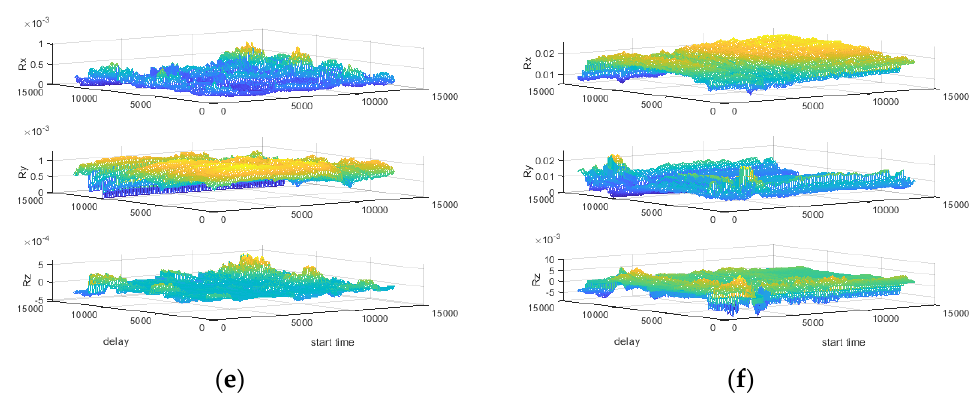
( e ) ( f ) Figure 3. The magnitude of each component of the magnetic field. ( a ) 0:00 on 6 March 2016, to 23:00 on 7 March 2016; ( b ) 0:00 on 13 October 2016, to 23:00 on 14 October 2016; ( c ) 0:00 on 27 May 2017, to 23:00 on 28 May 2017; ( d ) 00:00 on 8 September 2017, to 23:00 on 9 September 2017; ( e ) 0:00 on 27 September 2020, to 23:00 on 28 September 2020; ( f ) 00:00 on 4 November 2021, to 23:00 on 5 Novem- ber 2021.